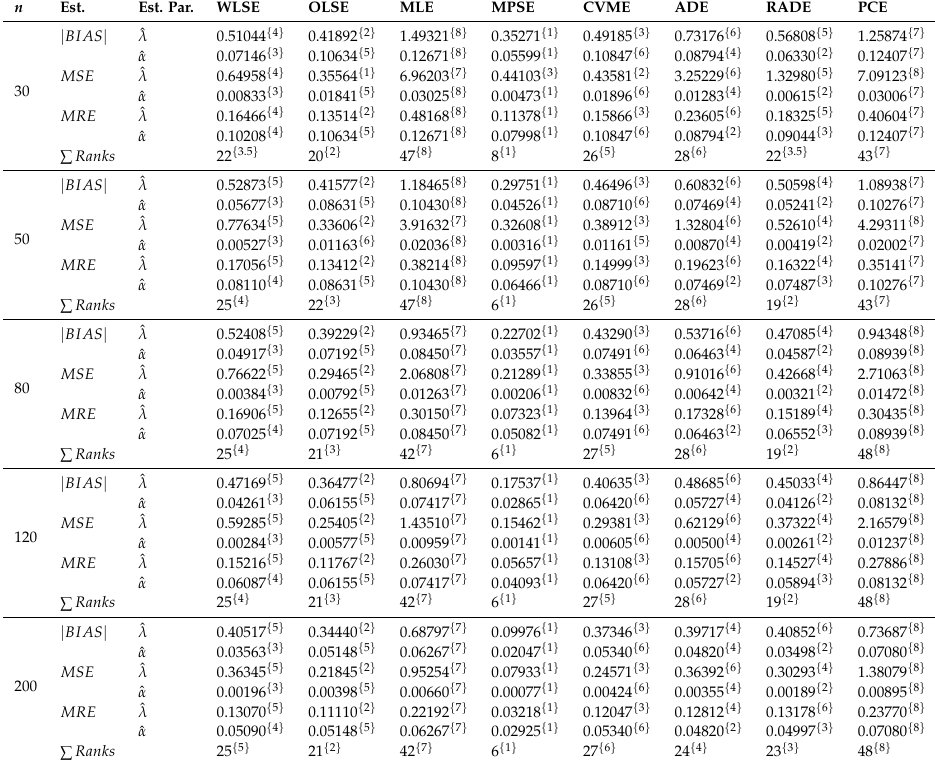
Table 8. Simulation results for φφφ = ( λ = 3.1, α = 0.7 ) (cid:124) .